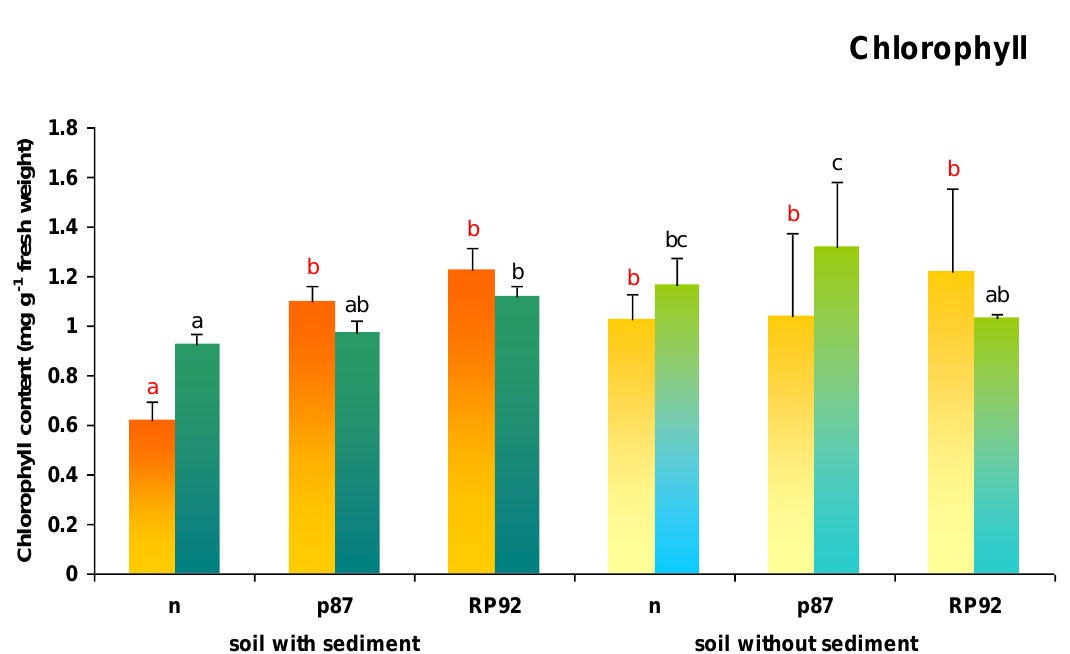
Figure 4. Total chlorophyll content in the leaves of T. patula and F. arundinacea grown on control and bottom sediments amended soil with or without (n) inoculation with bacterial strain p87 or RP92. The same letters denote groups that did not significantly differ (at p < 0.05; the Duncan post hoc test). Statistical significance was measured for each plant separately and the results were marked by different colors.